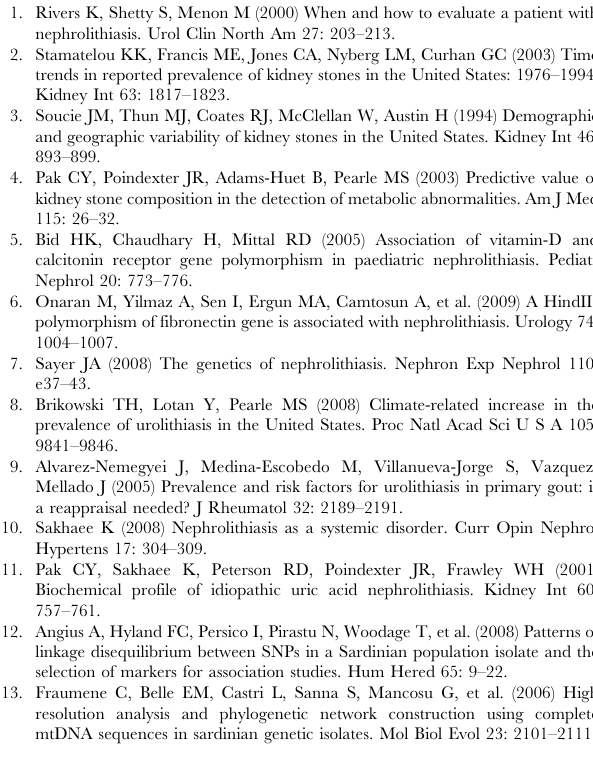
Table S2 Region 2q.